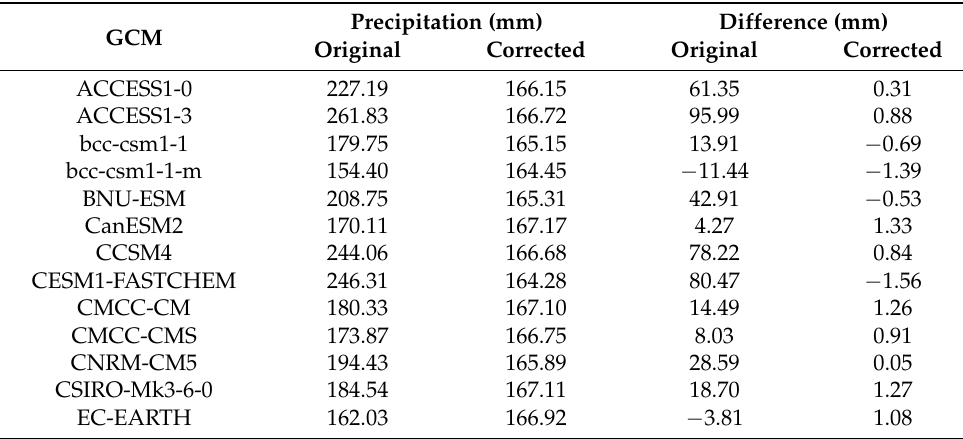
Table 7. The values of precipitation and its difference before and after modification in